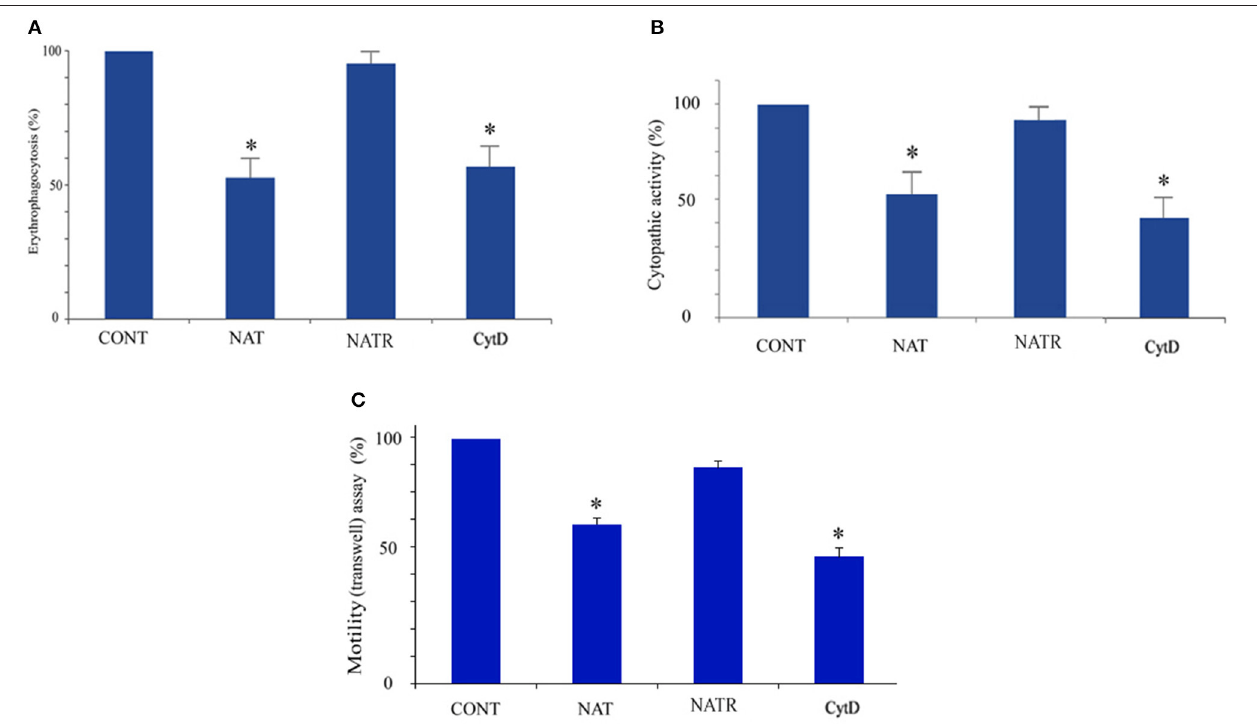
FIGURE 4 | Determination of cytoskeleton-dependent virulence markers in control E. histolytica trophozoites, NAT, NATR, and CytD-treated E. histolytica trophozoites Erythrophagocytosis (A) cytopathic activity (B) and motility (C) of control E. histolytica trophozoites, NAT, NATR, and CytD-treated E. histolytica trophozoites were examined. The value from control E. histolytica trophozoites for each activity was set at 100%. Data are displayed as the mean ± standard deviation of three independent experiments that were repeated twice with a P -value, 0.05. * p <